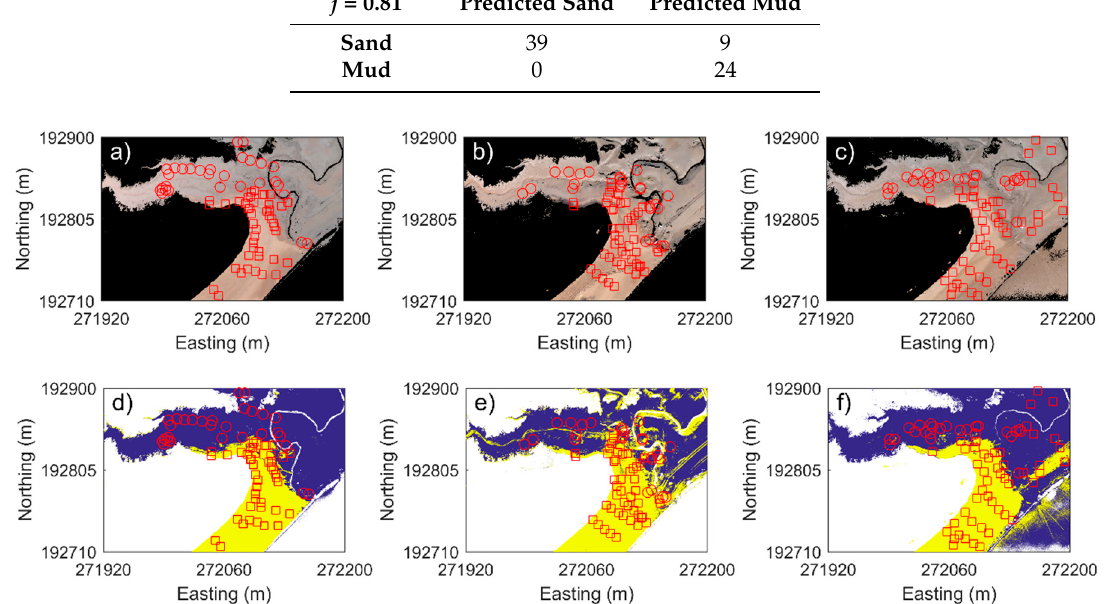
Table 8. Confusion matrix for classification from the third Neath flight using an ANN fed with HSV and NIR data channels. Calculated j values for the classification are also given in the upper left cell.